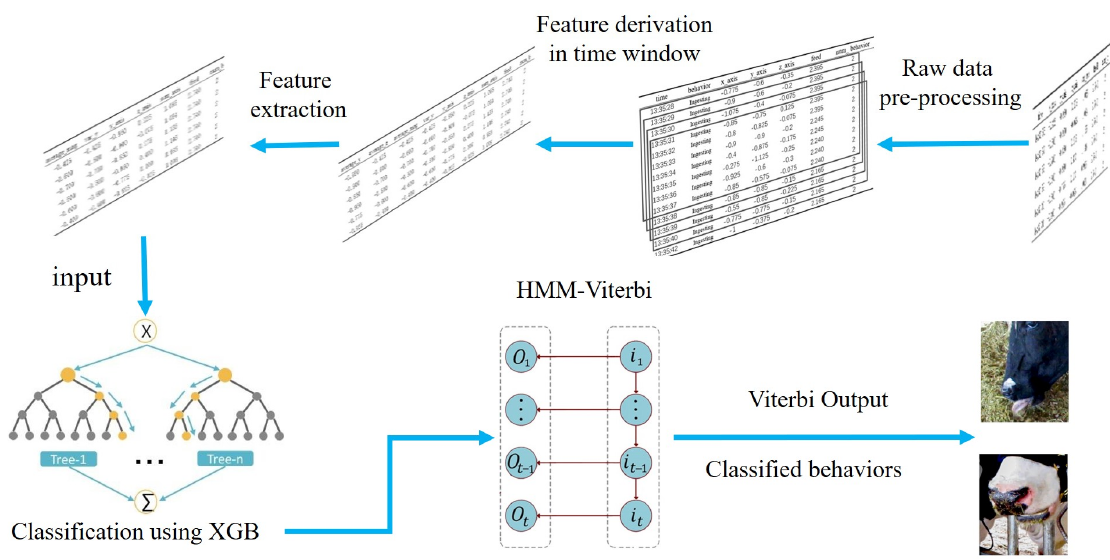
Figure 2. Flow chart of activity classification for jaw